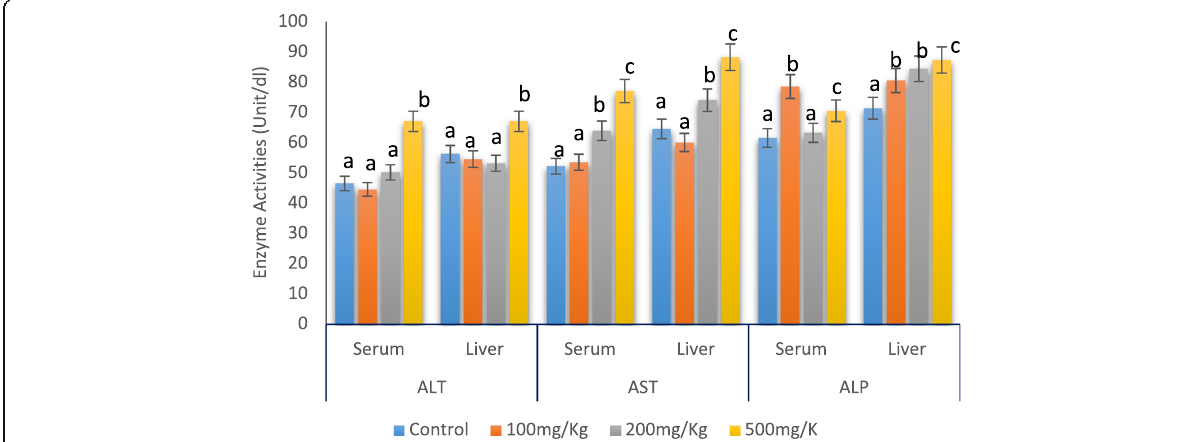
Fig. 3 Effect of Dennettia tripetala on activities of serum and tissue Liver function markers (ALT, AST, ALP)